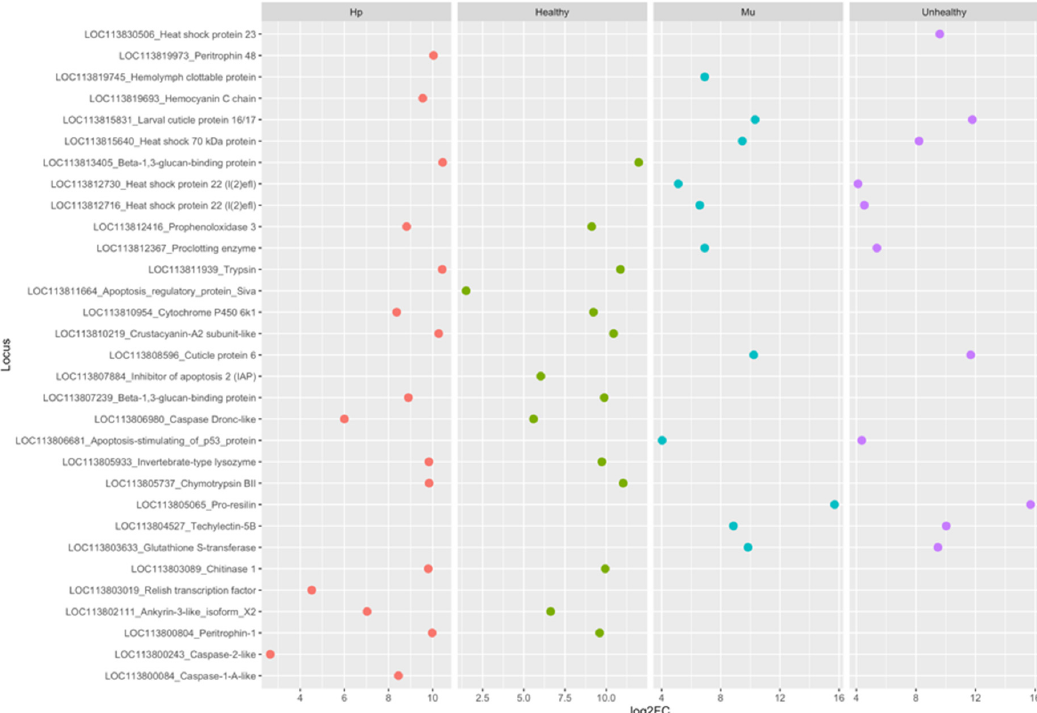
Figure 4. The main DEGs identified in the hepatopancreas (Hp) of WSSV-negative (Healthy) and in the muscle (Mu) of WSSV-negative (Unhealthy) Litopenaeus vannamei shrimps, with their respective log2FC values. WSSV: White Spot Syndrome Virus.